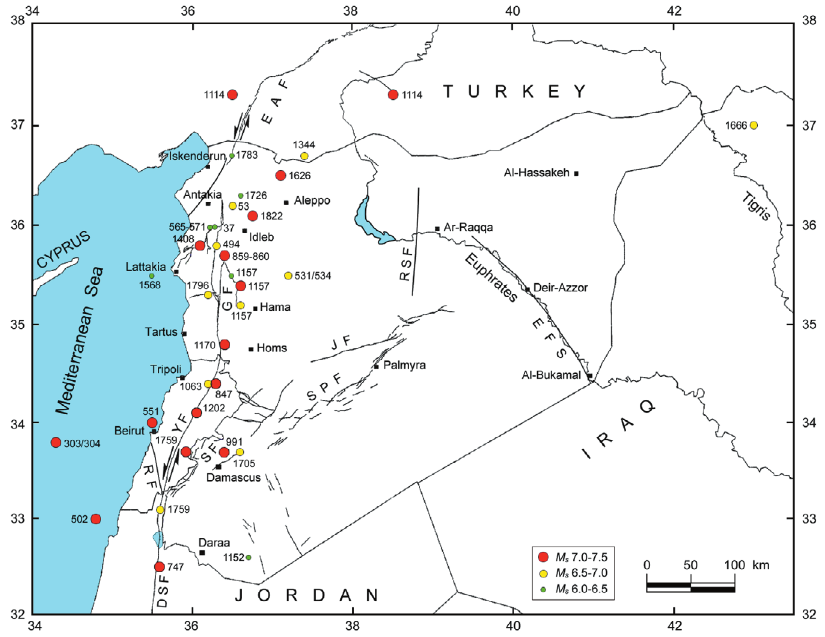
Fig. 21. Map of Syria and the surroundings showing the distribution of historical earthquakes epicenters (cir- cles). Dates of earthquakes are listed in table I. DSF – Dead Sea Fault system; EAF – Eastern Anatolian Fault system; EFS – Euphrates Fault System; GF – Al-Ghab Fault; RSF – Ar-Rassafeh Fault; RF – Roum Fault; SF – Serghaya Fault; SPF – Southern Palmyride Fault; YF – Al-Yammouneh Fault (faults are compiled from McBride et al. , 1990; Barazangi et al. , 1993; Gomez et al. ,